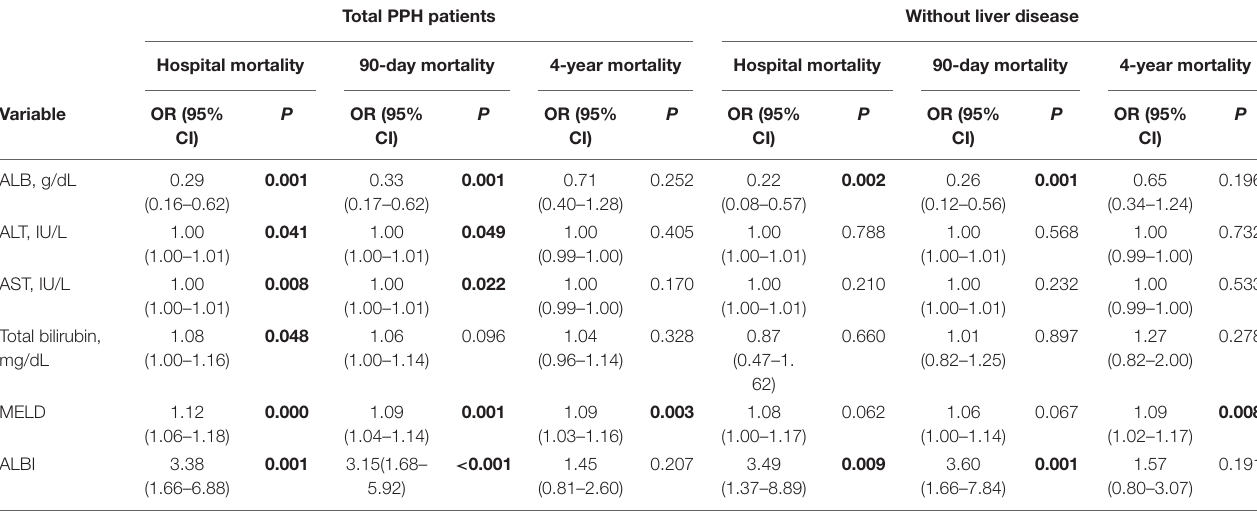
TABLE 6 | Univariate logistic regression analyses for prognosis in patients with